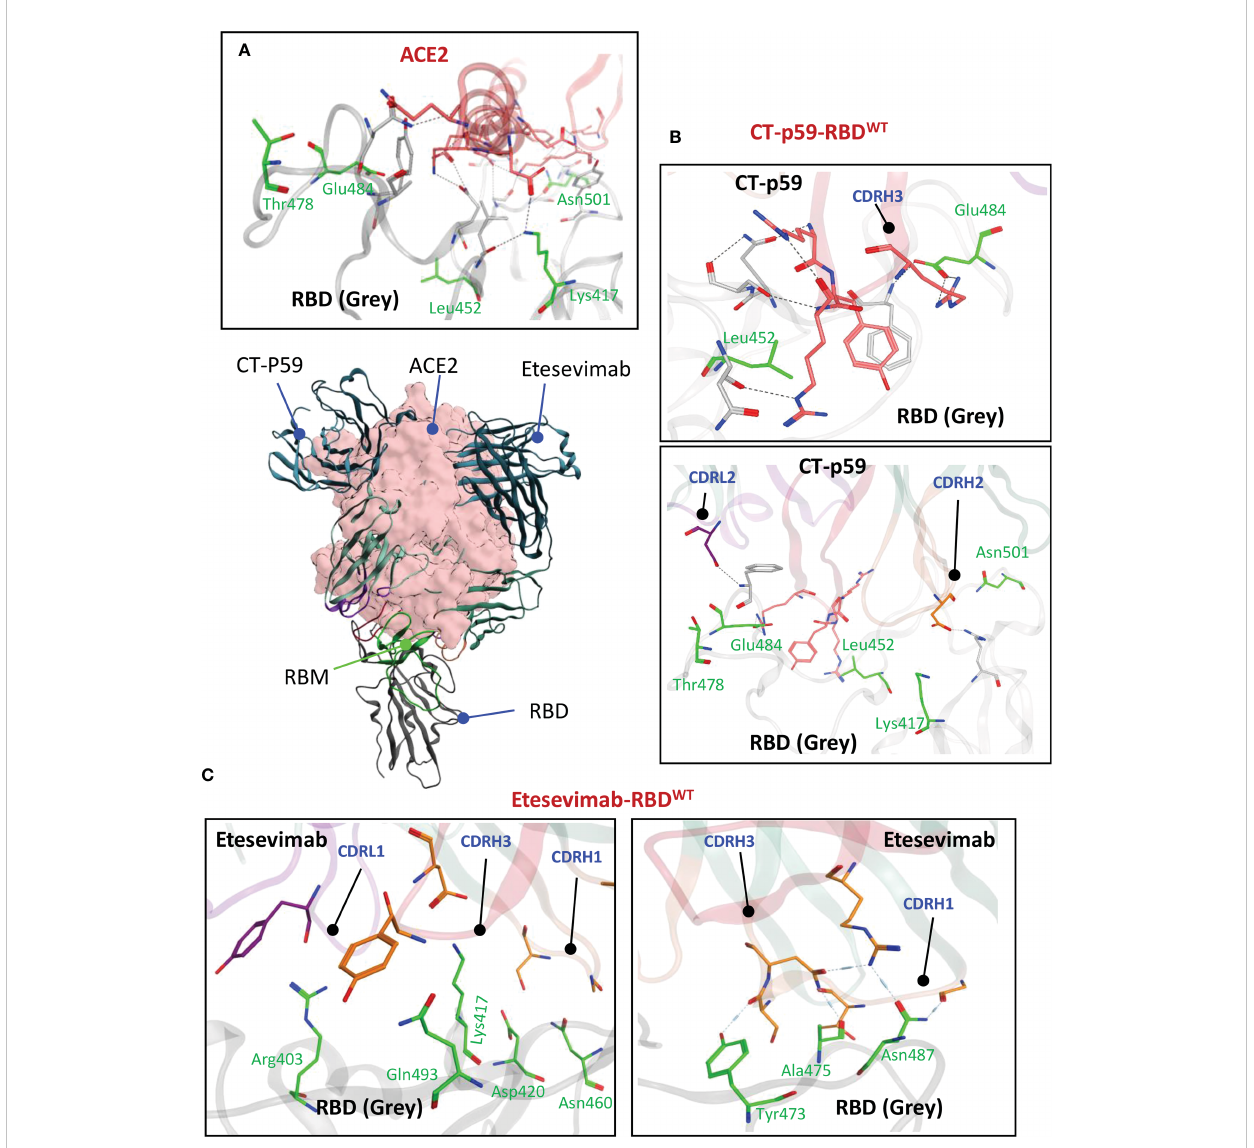
FIGURE 1 Monoclonal antibodies (mAbs) Etesevimab and CT-p59 neutralize SARS-CoV-2 and compete with ACE2 on RBD. (A) Both mAbs fully overlap with ACE2 and interact with receptor binding motif (RBM) in RBD. (B) CT-p59 utilizes its CDRs H2, H3 and L2 to engage with RBD. (C) Etesevimab binds RBD through its CDRs H1, H3, and L1. Amino acids in RBM that are shared by ACE, CT-p59 and Etesevimab are represented by green sticks and labeled green. Interface contacts along with their bonds-length, bonds-energies and bonds-type of both CT-p59 and Etesevimab are listed in Tables S1 and